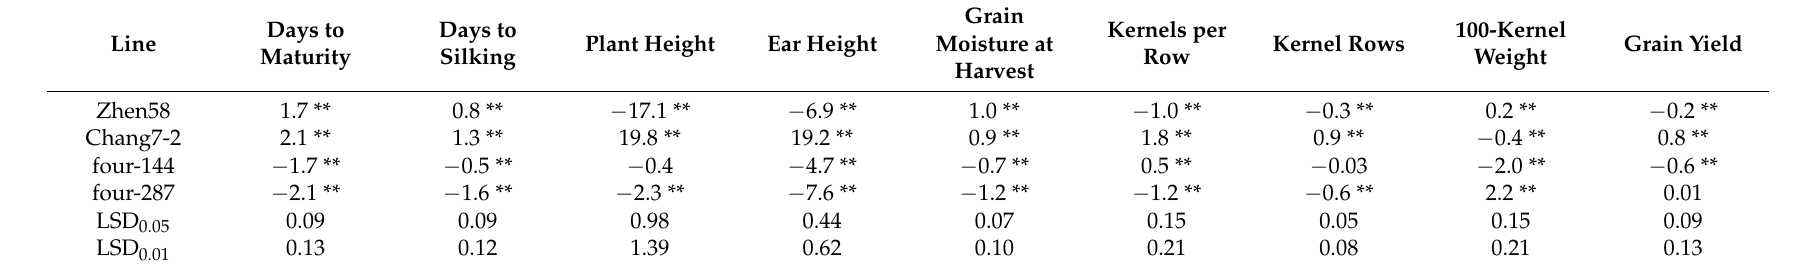
Table 11. The general combining ability of China tester lines for machine-harvest and yield